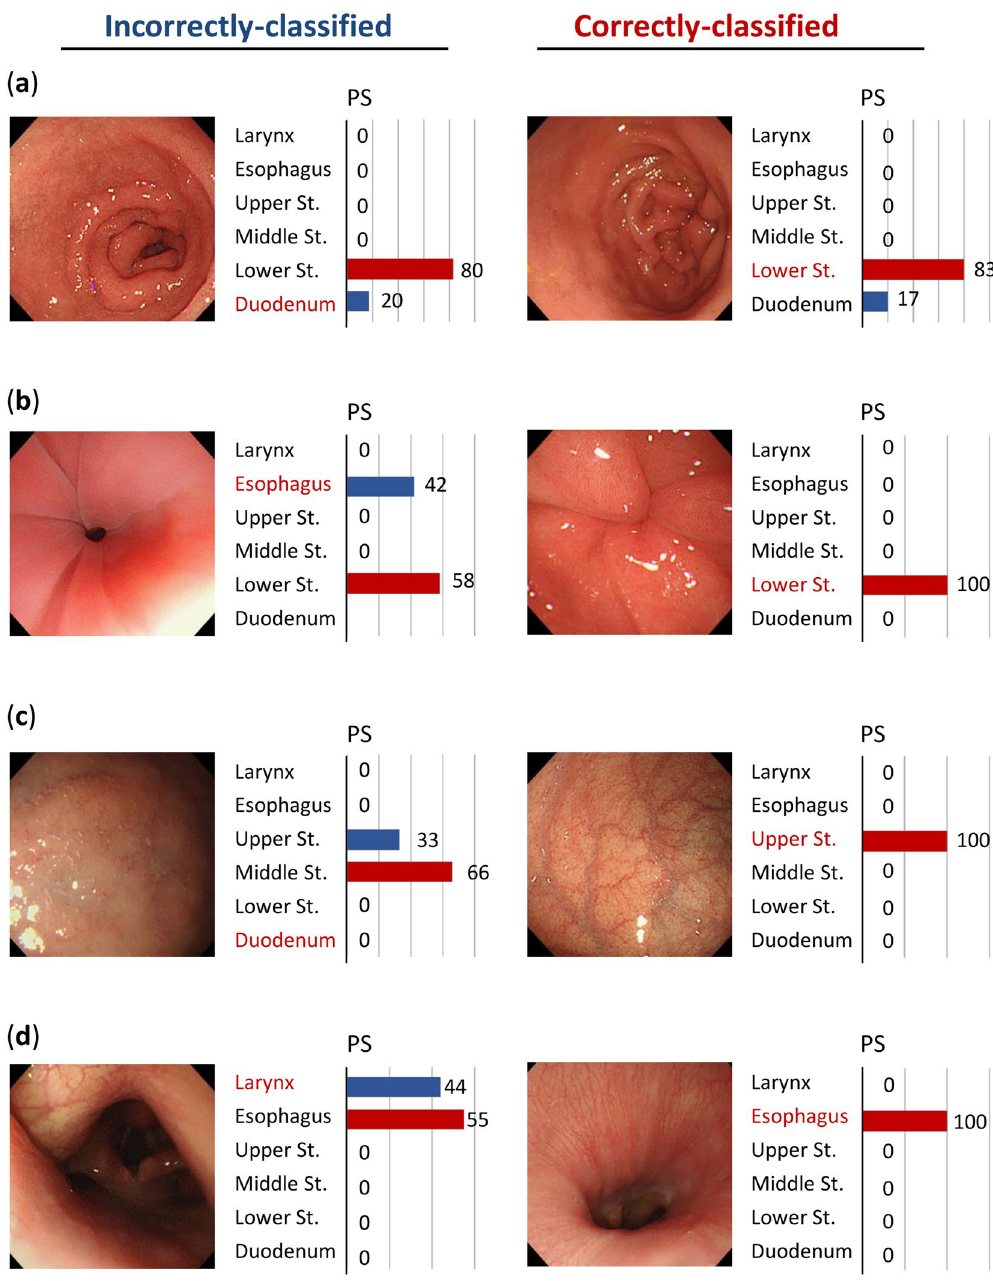
Figure 2. Examples of images which were correctly and incorrectly classified by the convolutional neural network (CNN). PS represents the probability score. ( a ) Duodenum image, which was incorrectly classified by the CNN as the lower stomach (left) and a correctly classified image from the duodenum (right). ( b ) Esophagus image, which was incorrectly classified by the CNN as the lower stomach (left) and a correctly classified image from the lower stomach (right). ( c ) Duodenum image, which was incorrectly classified by the CNN as the middle stomach (left) and a correctly classified image from the upper stomach (right). ( d ) Larynx image, which was incorrectly classified by the CNN as the esophagus (left) and a correctly classified image from the esophagus